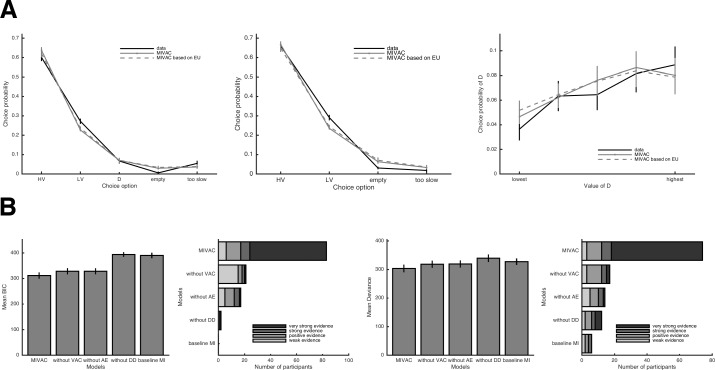
MIVAC with EU-based subjective values as inputs.(A) Comparison of qualitative predictions of MIVAC with EV or EU-based subjective values as input to the options’ accumulators. The two variants make very similar predictions. (B) Quantitative model comparison between all MIVAC variants with EU-based subjective values. The full model still provides the best account of choices with D present (left panels) and choices with D absent (right panels). Details on the implementation of EU-based subjective values within MIVAC are provided in the Methods.